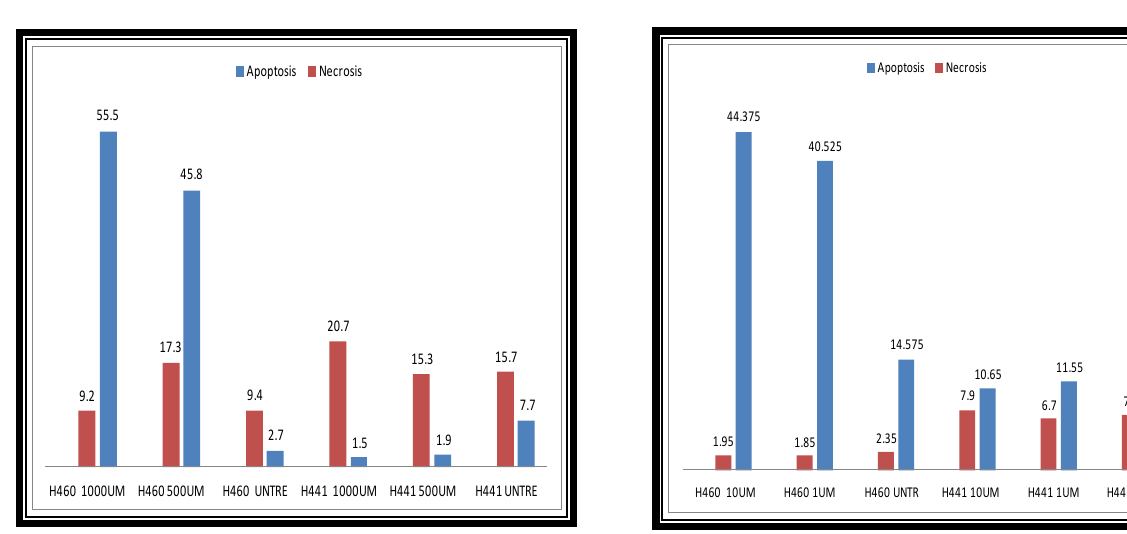
Figure 3 : Apoptosis and necrosis percentages after 24 hr of nicotine treatment with concentrations (1 μ M and 10 μ M) in H460 and H441 lung cancer cell.